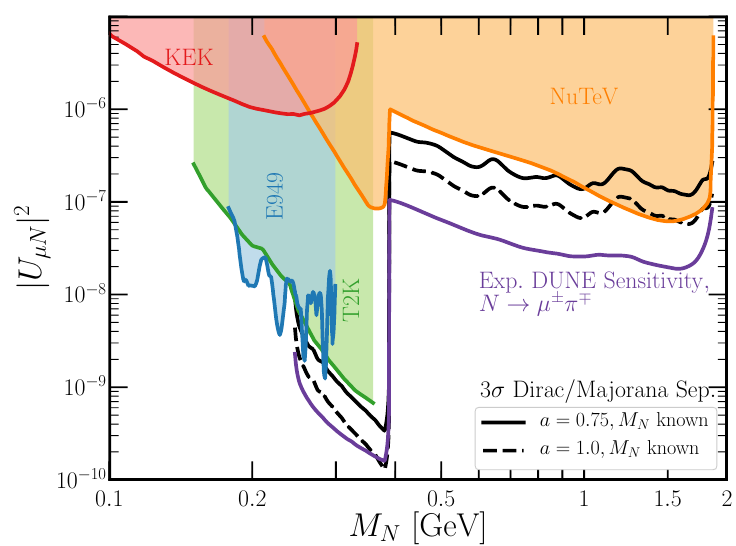
Figure 31 . Expected Dirac/Majorana separation capability in the (cid:12)nal state N purple curve is the expected sensitivity from the search N fermion (in contrast to the Dirac-neutrino assumption in (cid:12)gure 25). The dashed black curve is the 3 (cid:27) Dirac/Majorana distinction assuming perfect knowledge of M N and the e(cid:14)ciency factor a = 1. The solid black curve is 3 (cid:27) Dirac/Majorana distinction assuming perfect knowledge of M N and e(cid:14)ciency factor a = 0 :